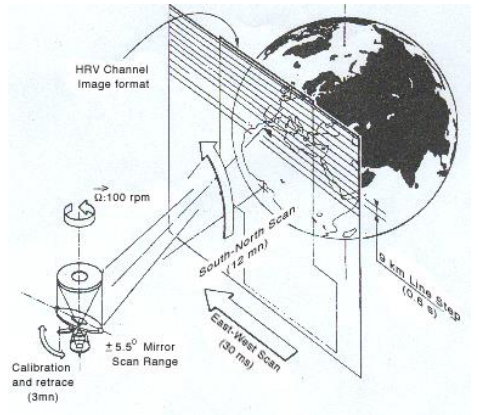
Figure 1. SEVIRI Earth imaging principle (EUMETSAT, 2017).